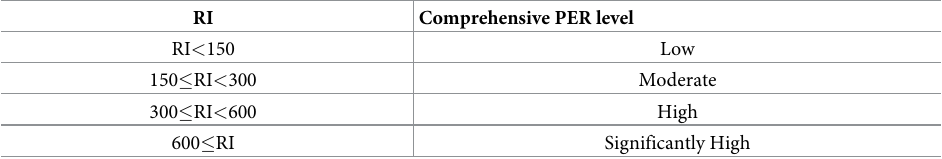
Table 5. Comprehensive potential ecological risk (PER) levels classification.